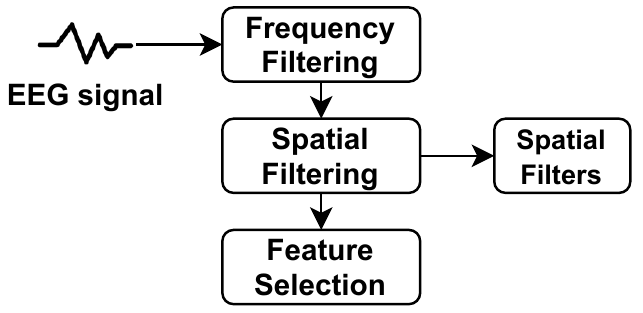
Figure 5. The basic structure of CSP